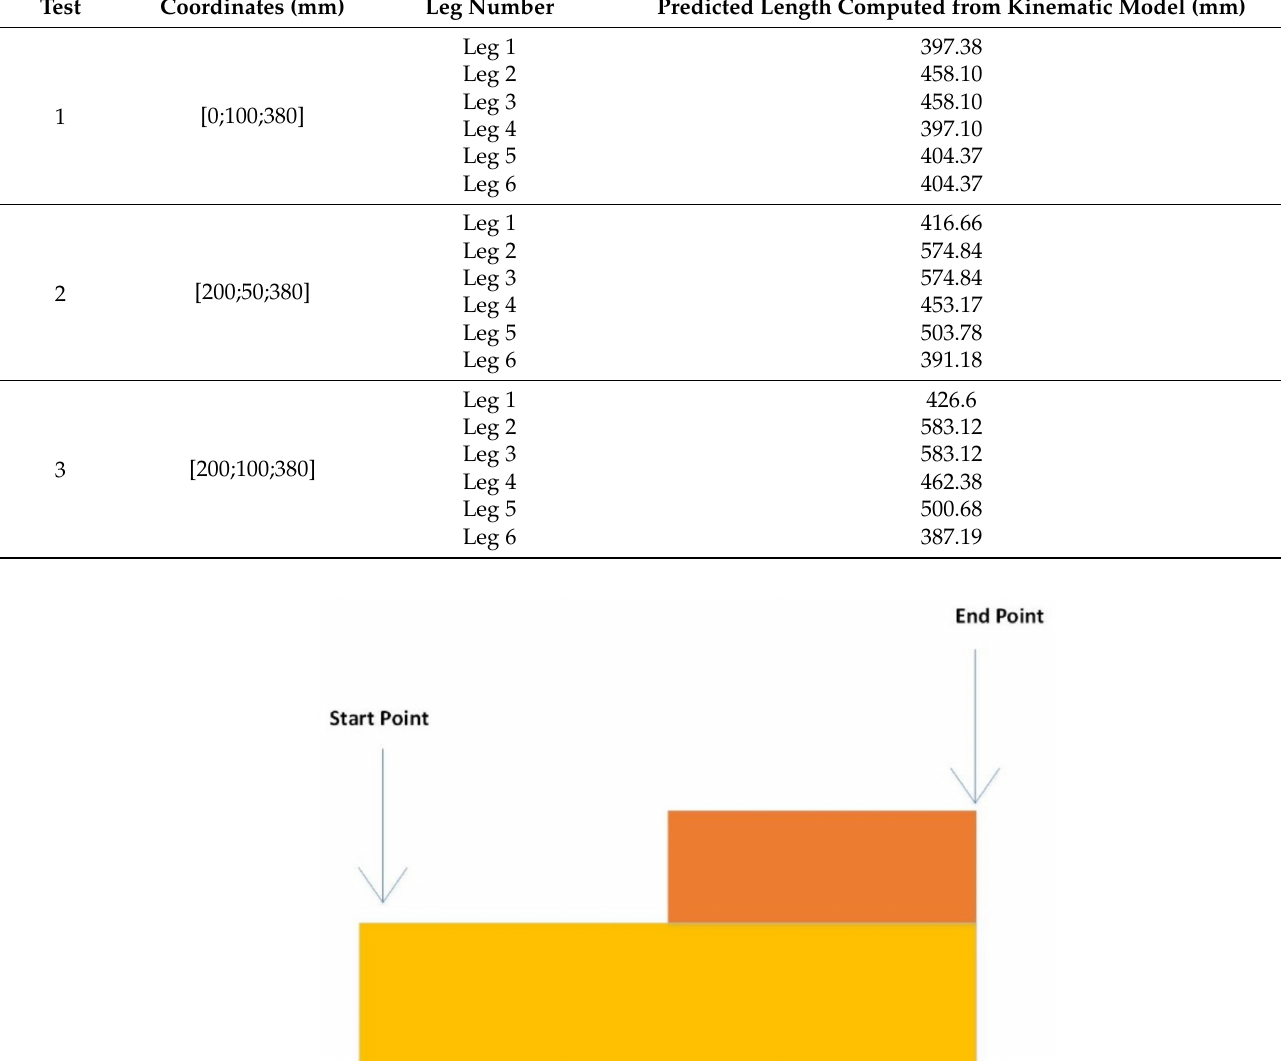
Table 2. Tests results for verification of kinematics model.